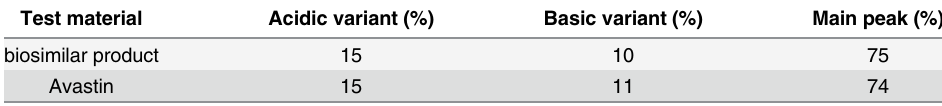
Table 1. Analytical results by the CEX-HPLC method for the biosimilar product and Avastin.